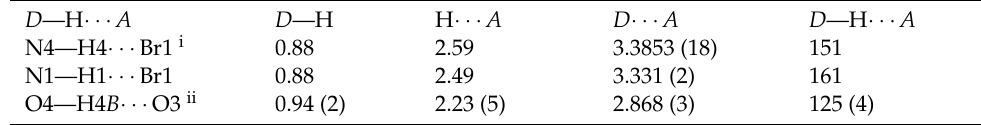
Figure 5. ( a , c ) part of the crystal packing of (II) and (V), hydrogen bonds are shown as green and yellow dashed lines, H atoms not involved in hydrogen bond have been omitted for clarity. ( b , d ) 1,2,3-Connected trinodal topological 1D net representing the hydrogen bond chain structure of (II) and (V). Table 4. Hydrogen-bond geometry (Å, º) for